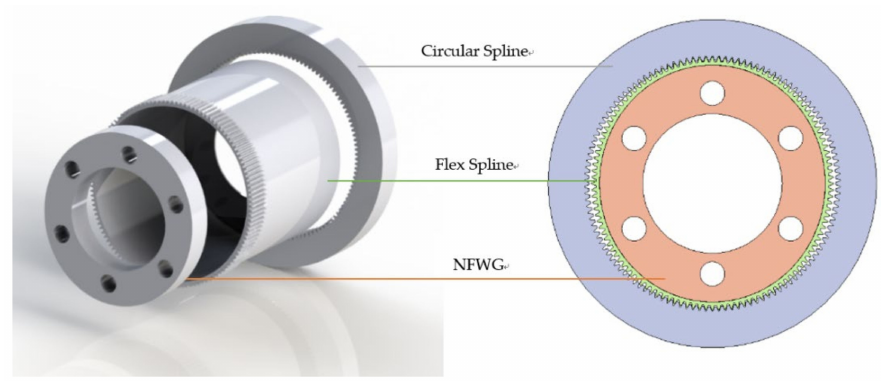
Figure 1. Components and geometry of the HD with NFWG.